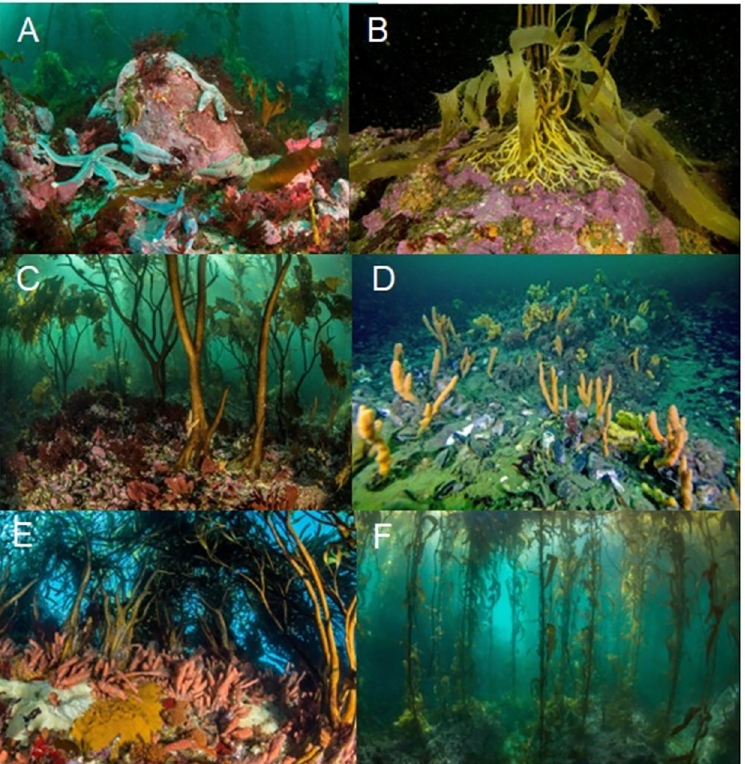
Fig 2. Representative marine benthic habitats of southern Patagonia. A. Cape Horn, B. Mitre Peninsula, Argentina, C. Isla de los Estados, Argentina, D. Kawe´sqar National Reserve, Chile, E. and F. Diego Ramı´rez,